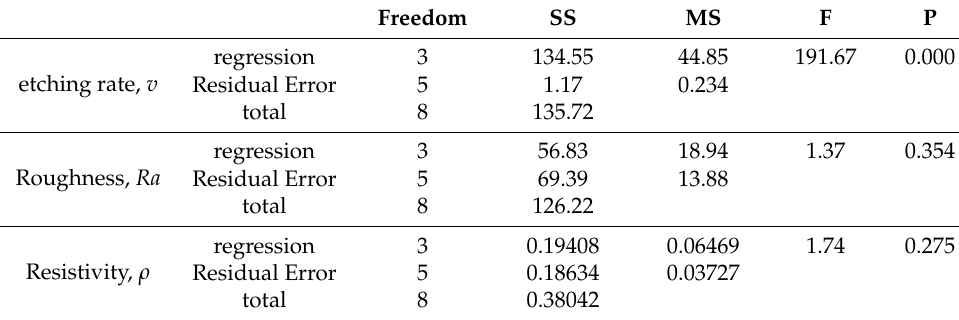
Table 10. Ion beam etching regression model analysis of variance.